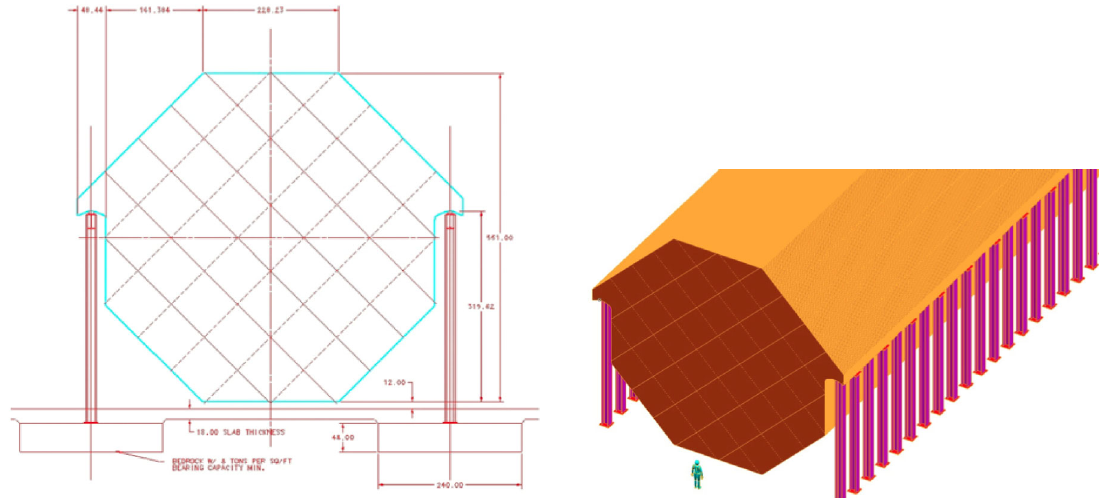
FIG. 1. Schematic representations of the MIND for a neutrino factory.